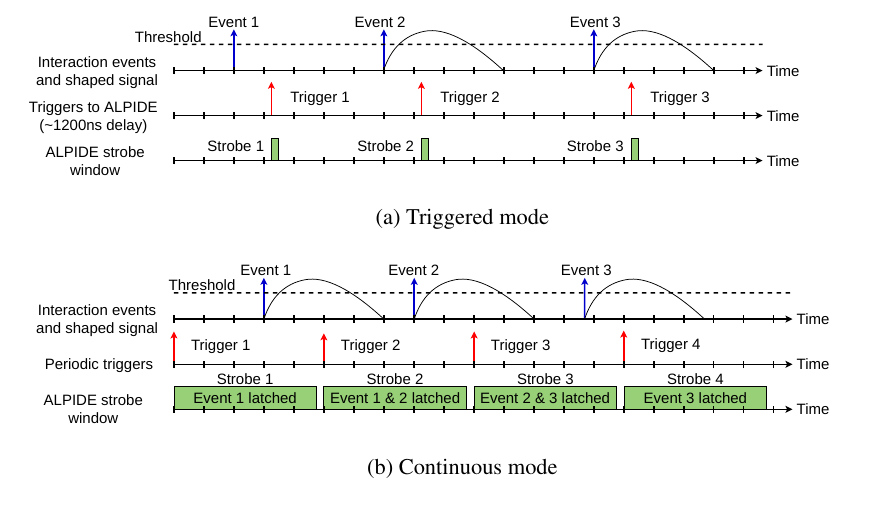
Figure 2: Trigger modes for the ALPIDE